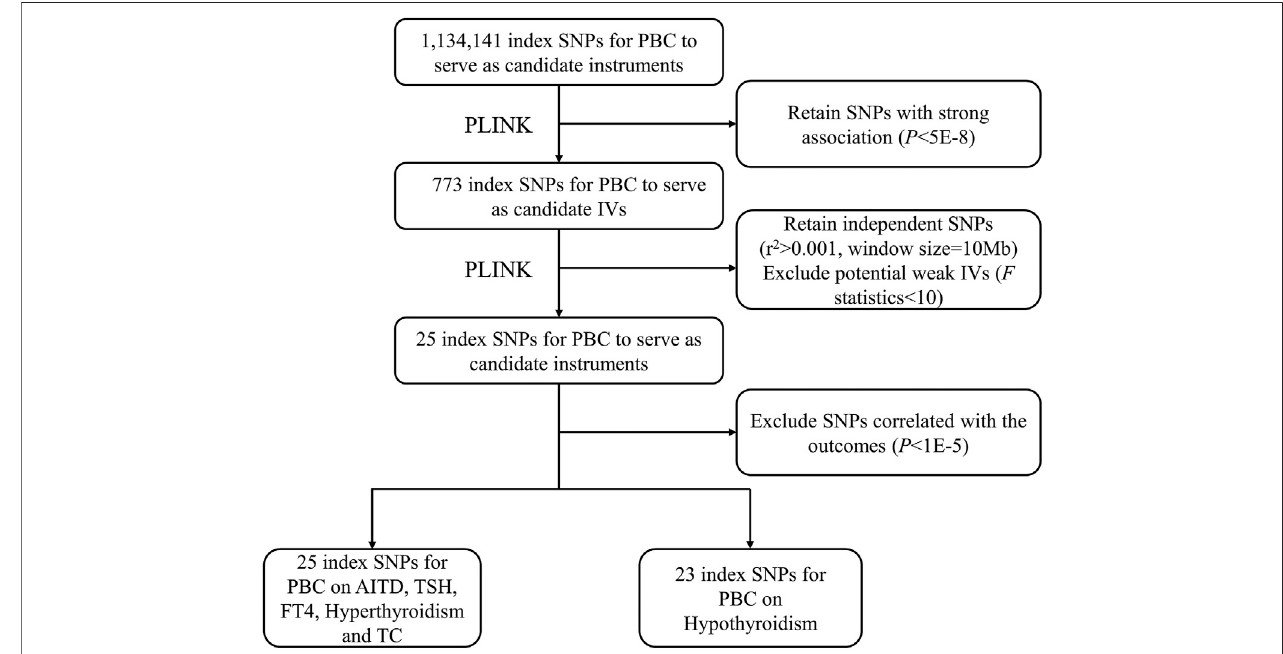
FIGURE1| The fl owchartforIVselection.The fl owchartshowstheselectionprocessofPBCIVstoestimatethecausaleffectsonAITD,TSH,FT4,hyperthyroidism, hypothyroidism, and TC. First, we use p < 5.00E − 8 to select index SNPs to ensure that they strongly associate with PBC. Second, we use r 2 > 0.001 in the range of 10 Mb to select independent index SNPs. We treat the EUR of 1000 Genomes Project as the reference panel. The fi rst two steps are completed by PLINK. Finally, we obtain 25 IVs on AITD, TSH, FT4, hyperthyroidism, and TC and 23 IVs on hypothyroidism. IV, instrumental variable; PBC, primary biliary cholangitis; AITD, autoimmune thyroid disease; TSH, thyroid-stimulating hormone; FT4, free thyroxine; TC, thyroid cancer; SNP, single-nucleotide polymorphism.